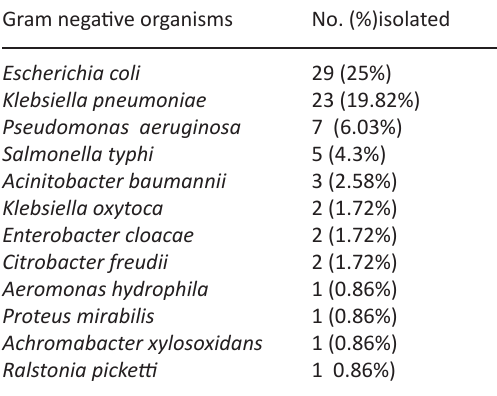
Table 1. Total number of gram negative isolates from blood culture (n=79) Gram negative organisms